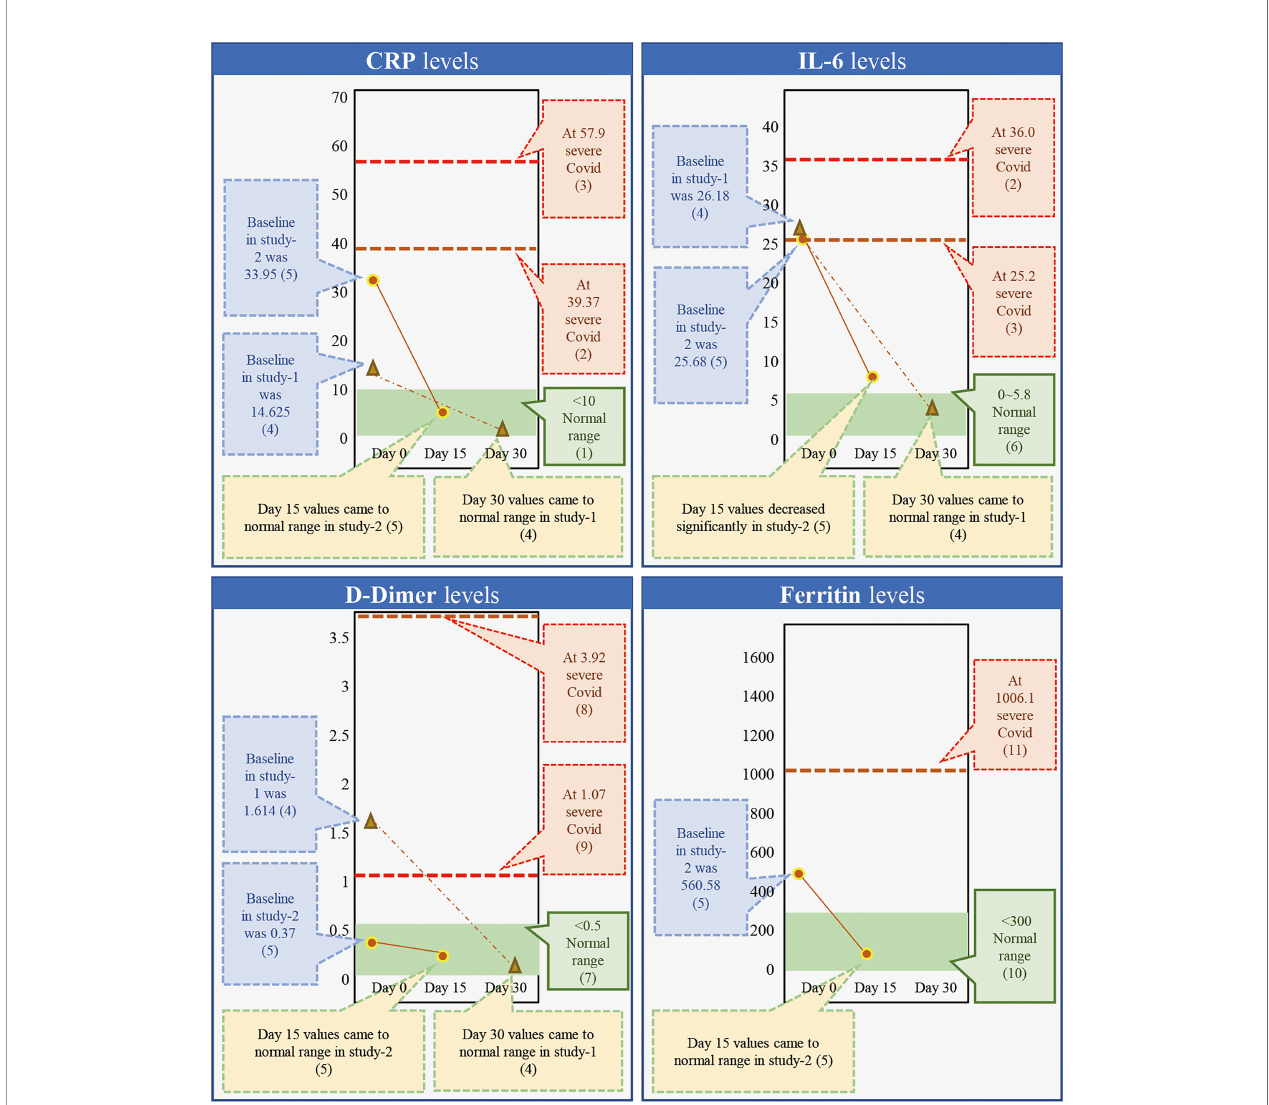
FIGURE 1 | Comparison of markers of in fl ammation, coagulation, and immunity (CRP, IL-6, D-dimer, and ferritin) associated with severe COVID-19 with a high risk of mortality from the literature against the outcome of studies done on consumption of Aureobasidium pullulans strain (AFO-202 and N-163)-derived b -glucans in COVID-19 patients demonstrates that the marker levels were regulated to the normal range after 15 days of consumption and the values remained in the normal range post-30 days as well [(1) Ref. no (56).; (2) Ref. no (54).; (3) Ref. no (55).; (4) Ref. no (41).; (5) Ref. no (42).; (6) Ref. no (57). (7) Ref. no (58).; (8) Ref. no (59).; (9) Ref. no (60).; (10) Ref no (61).; (11) Ref no